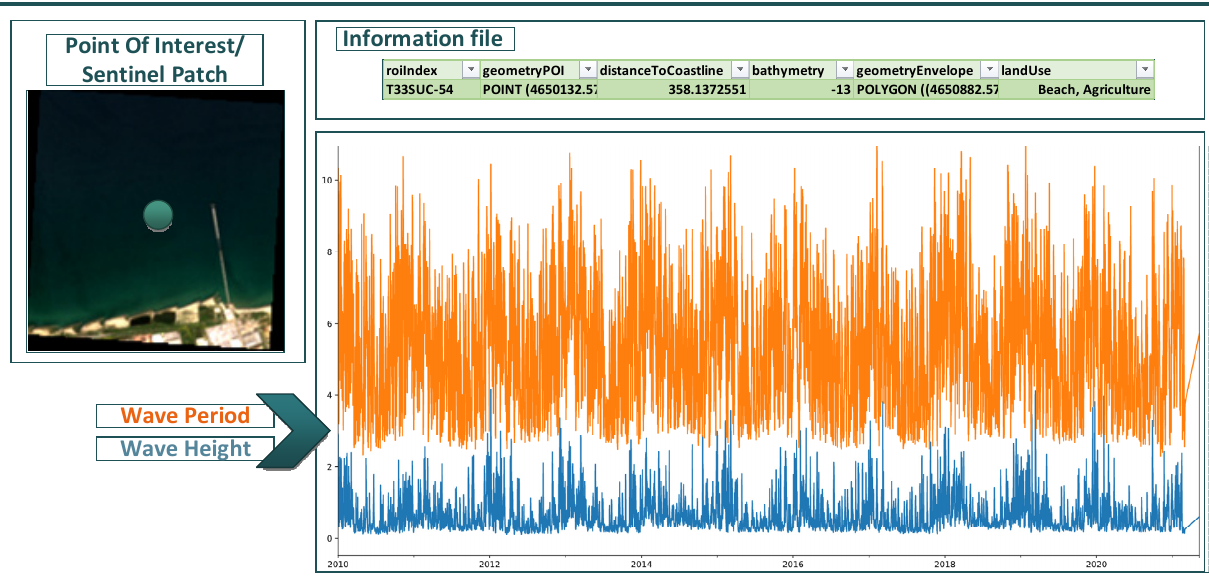
Figure 2. Example of a potential WEC installation point.